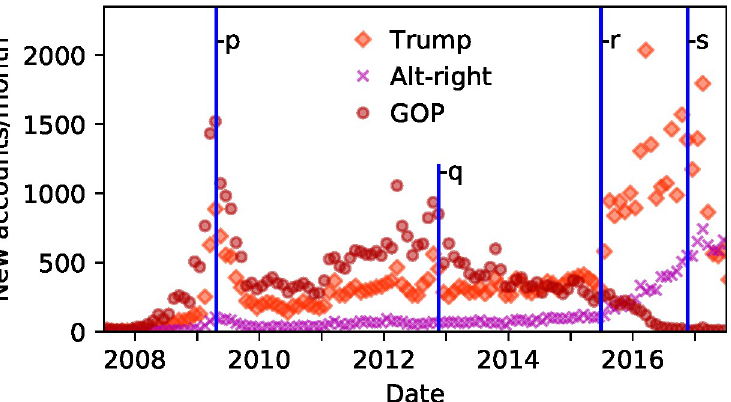
Fig 2. Changing growth rates of each group. Shows how a decrease in new accounts aligned with the GOP group coincided with a growth in the Trump and Alt-right groups, especially after Trump’s campaign announcement in June 2015. We plot the growth rates over time of the three focal groups: Trump (orange diamonds), Alt-right (purple Xs), and GOP (red circles). Events shown: p , Tax Day Events on 12 April 2009 associated with the Tea Party Movement; q